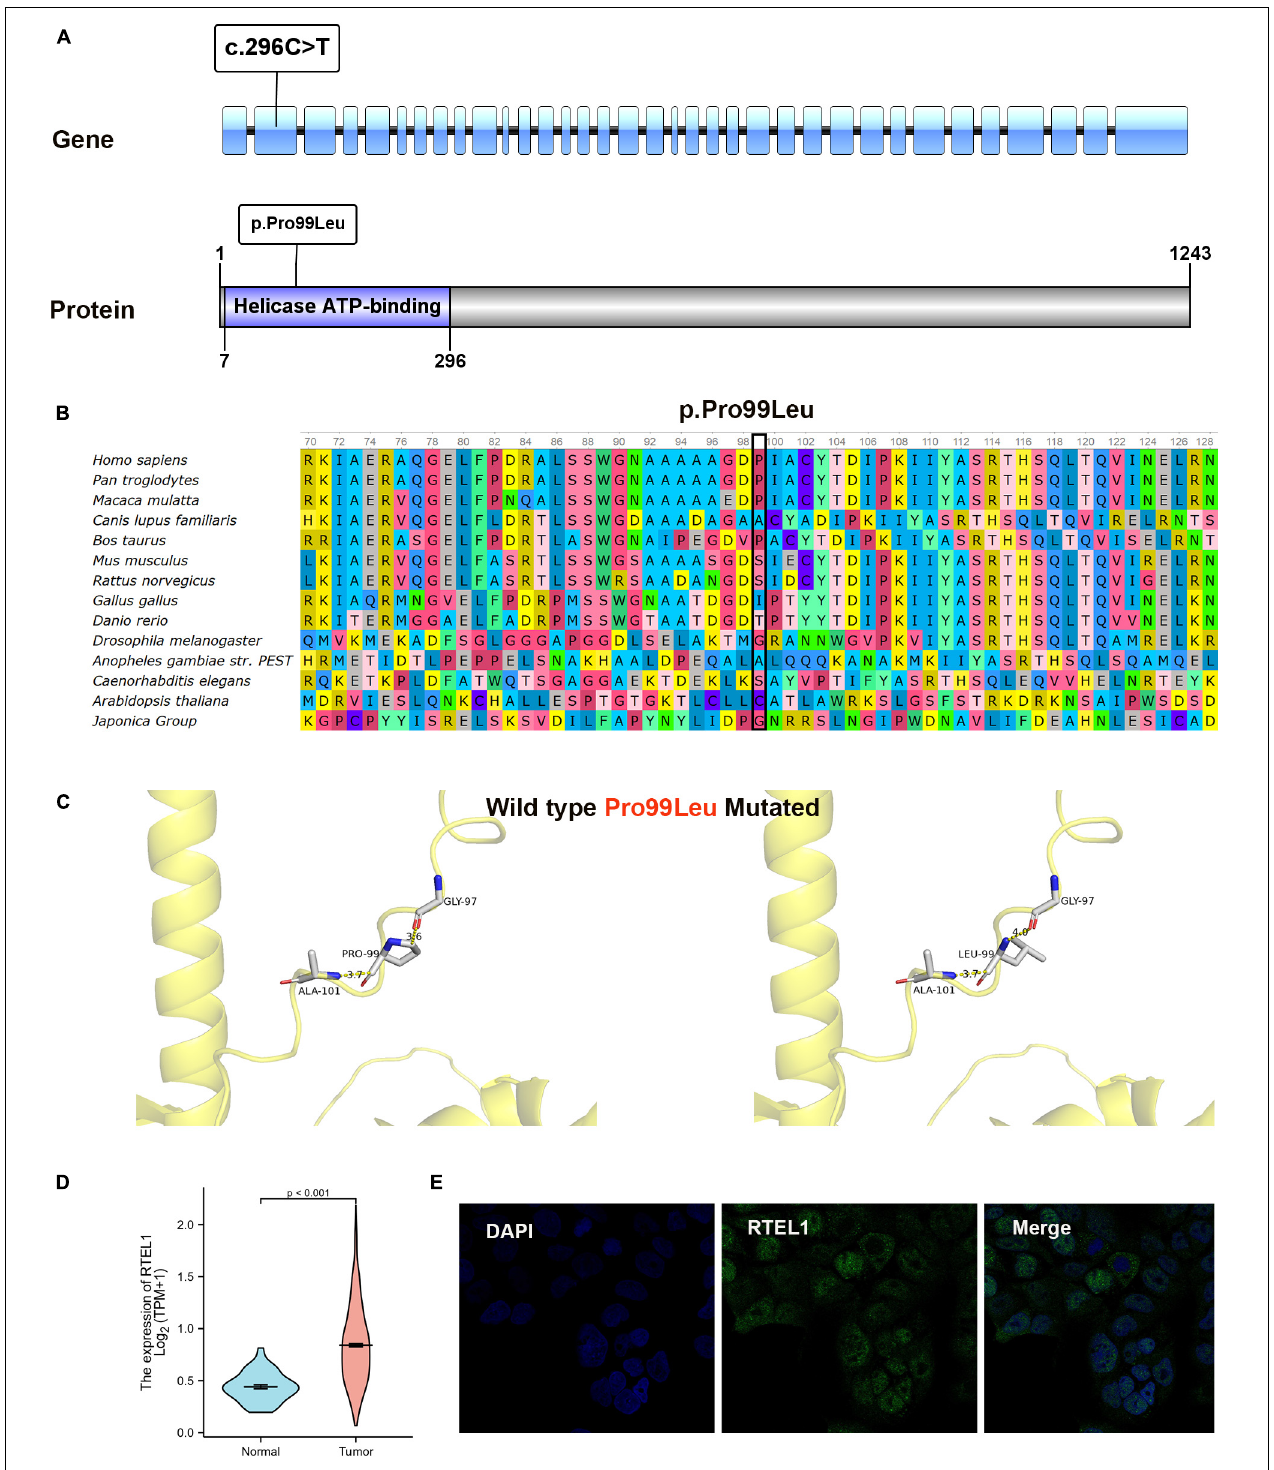
FIGURE 2 | Bioinformatics analysis results of RTEL1. (A) The location of variant c.296C > T (p.Pro99Leu) in gene and protein. (B) Conservation status of amino acid residue of the mutation site across various species. (C) Wild and mutated type of the p.Pro99Leu variant compared by PyMol. (D) The differential expression of RTEL1 mRNA in colorectal cancer ( n = 647) and normal control ( n = 51) in TCGA. (E) The protein expression of RTEL1 in colorectal adenocarcinoma cell line Caco2 in the Human Protein Atlas.